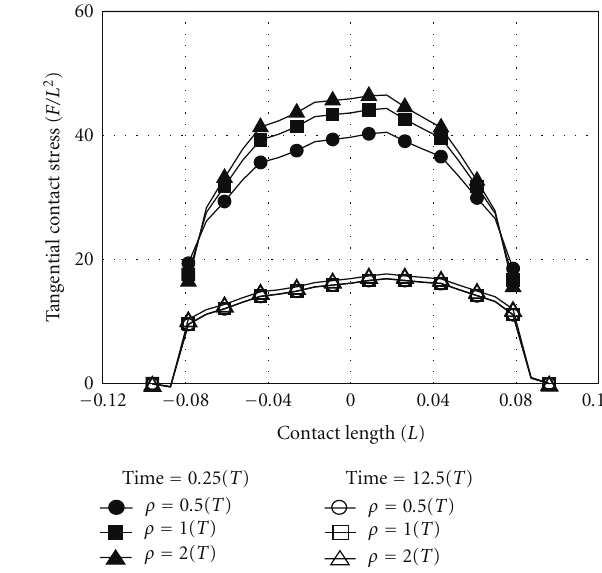
Figure 15: E ff ect of ρ on the contact pressure distribution. Figure 16: E ff ect of ρ on the tangential contact stress distribution.